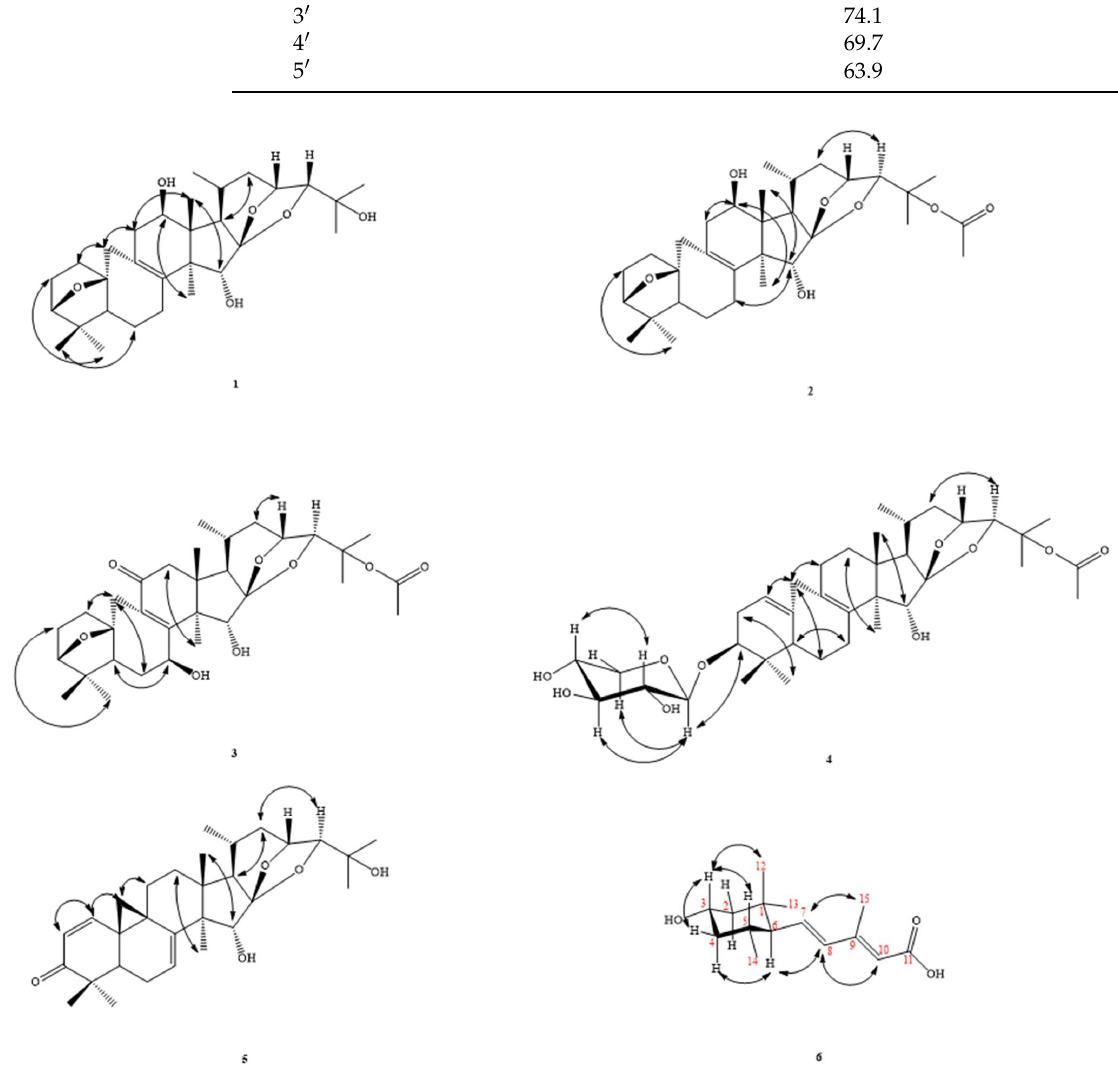
Figure 3. Major NOESY ( ↔ ) contacts of 1 ‒ 6 .